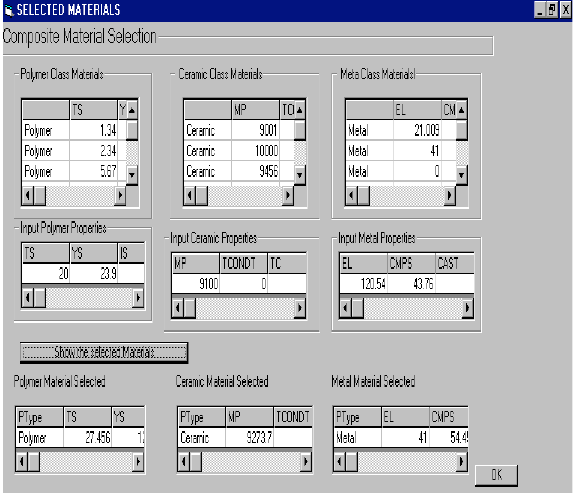
Fig. 4: Input Design requirement form